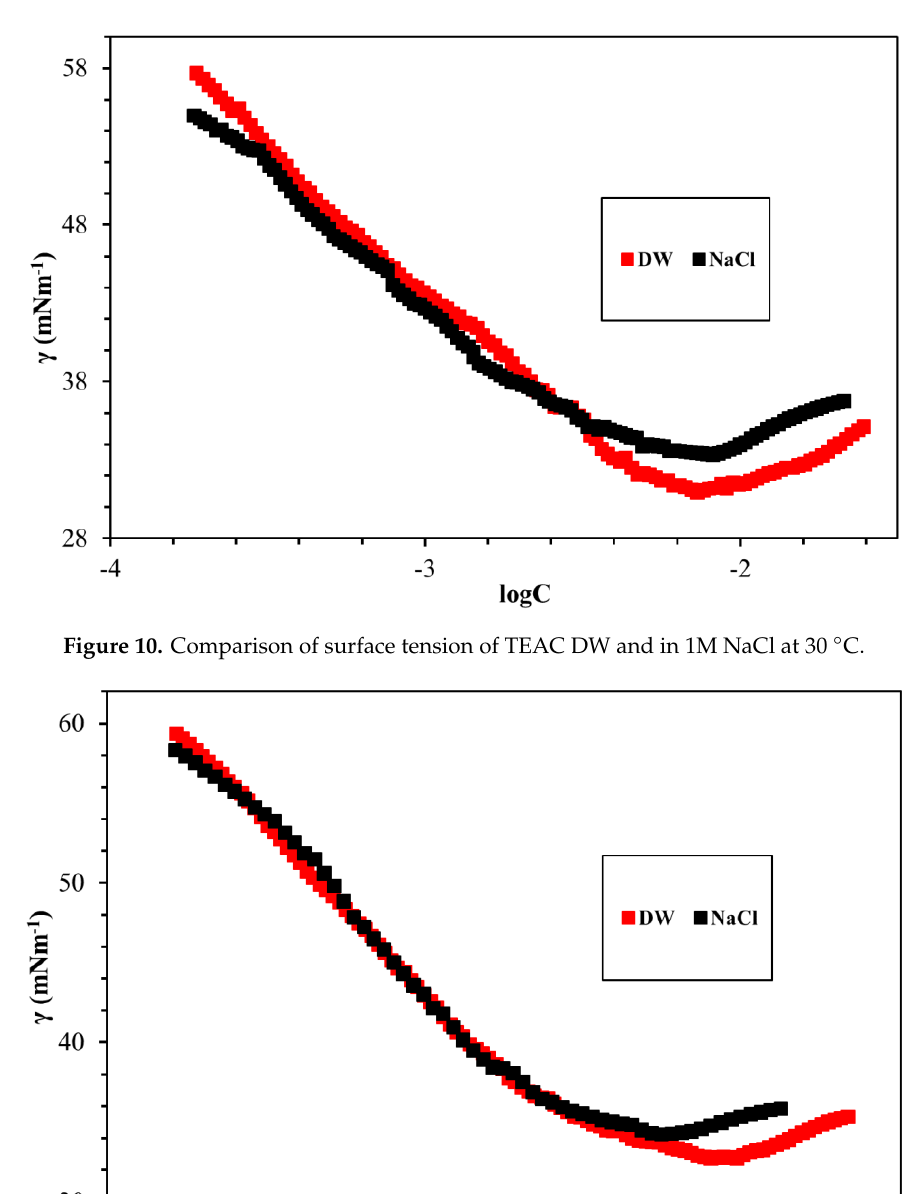
Figure 9. The surface tension-logC plots of NEAC, NEAS , and NEAH in 1M NaCl at 30 °C.